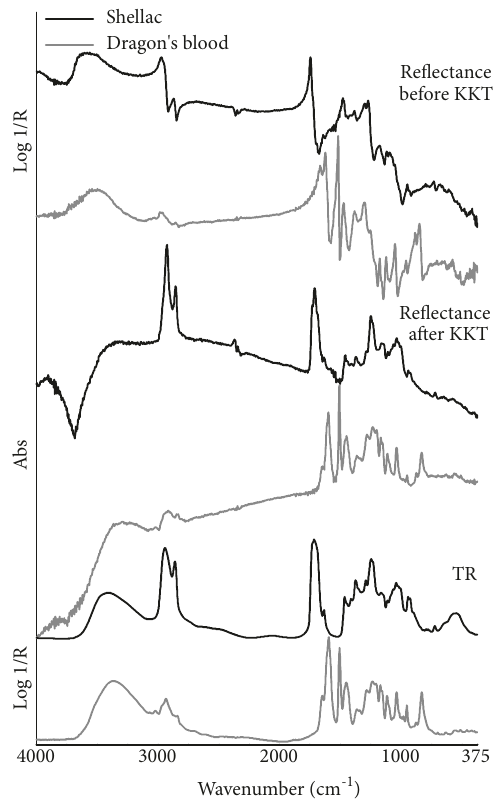
Figure 8: FTIR spectrain themid-infrared region of thestudied not (exclusively) terpenoid-based resins (black line: shellac, gray line: dragon’s blood) using different analysis modes. From top to bottom: total reflection mode before the KKT correction, total reflection mode after the KKT correction, and transflection